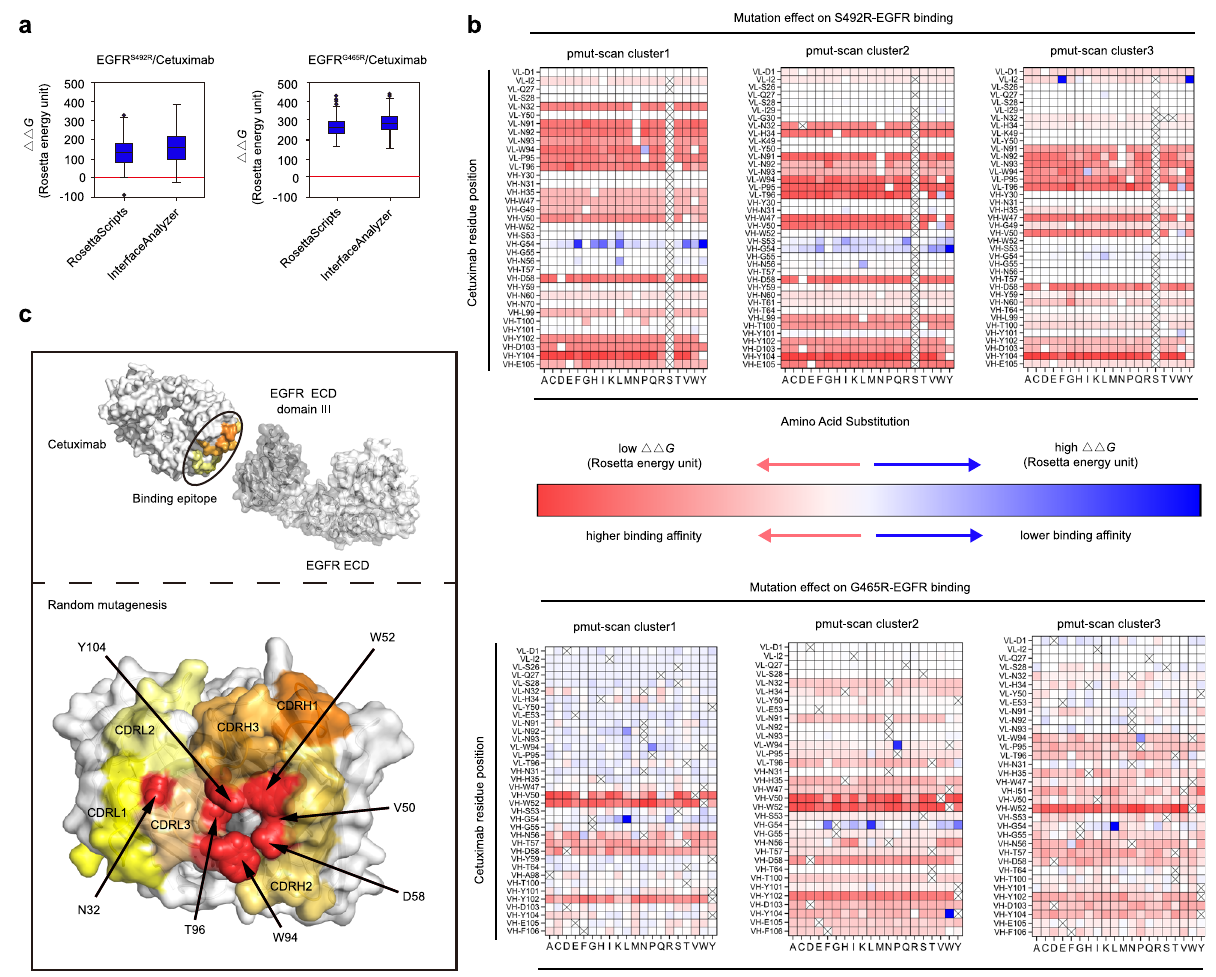
Fig.3|In-silicoidenti fi cationofresiduesessentialforrestorationofcetuximab binding. a The changes in binding energies ( ΔΔ G ) caused by the EGFR S492R or G465R mutation were analyzed by RosettaScripts and InterfaceAnalyzer ( n =100). The middle line in the boxplot displays the median, the box indicates the fi rst and third quartile, whiskers the 1.5 interquartile range (IQR). b The ΔΔ G values for